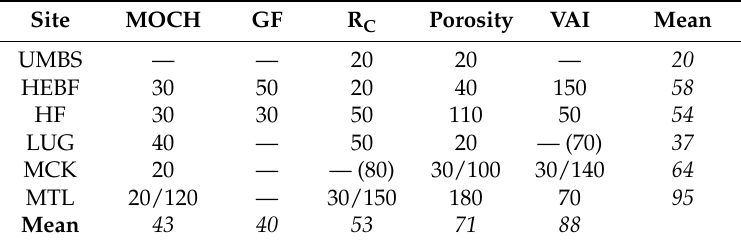
Table 2. Distance or distances (in meters) at which the z -score from Incremental Autocorrelation analysis reached a statistically significant peak for canopy structural complexity metrics across six forested landscapes in eastern USA. “—” indicates no significant peak was found in the data, number in parentheses indicates the distance of the non-significant peak z-score on the curve if there was one. Site